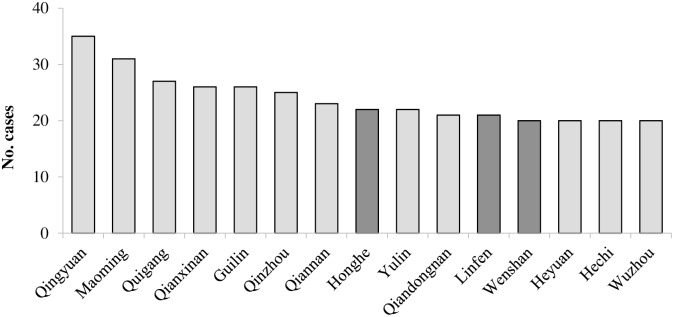
The variation of average cases in high risk prefectures from 2010 to 2014 compared with 2004 to 2009.Note: The dark gray column means the average cases during 2010 to 2014 were increase than 2004 to 2009, the light gray column means cases were decrease than before.